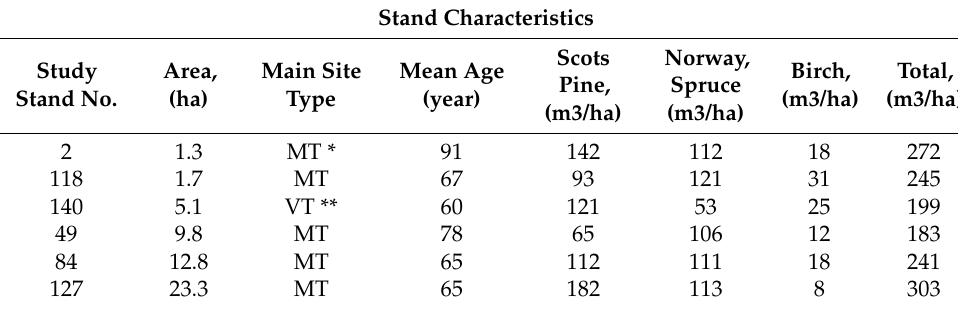
Table 1. Stand volumes by tree species in the study stands at time of cutting. Stand